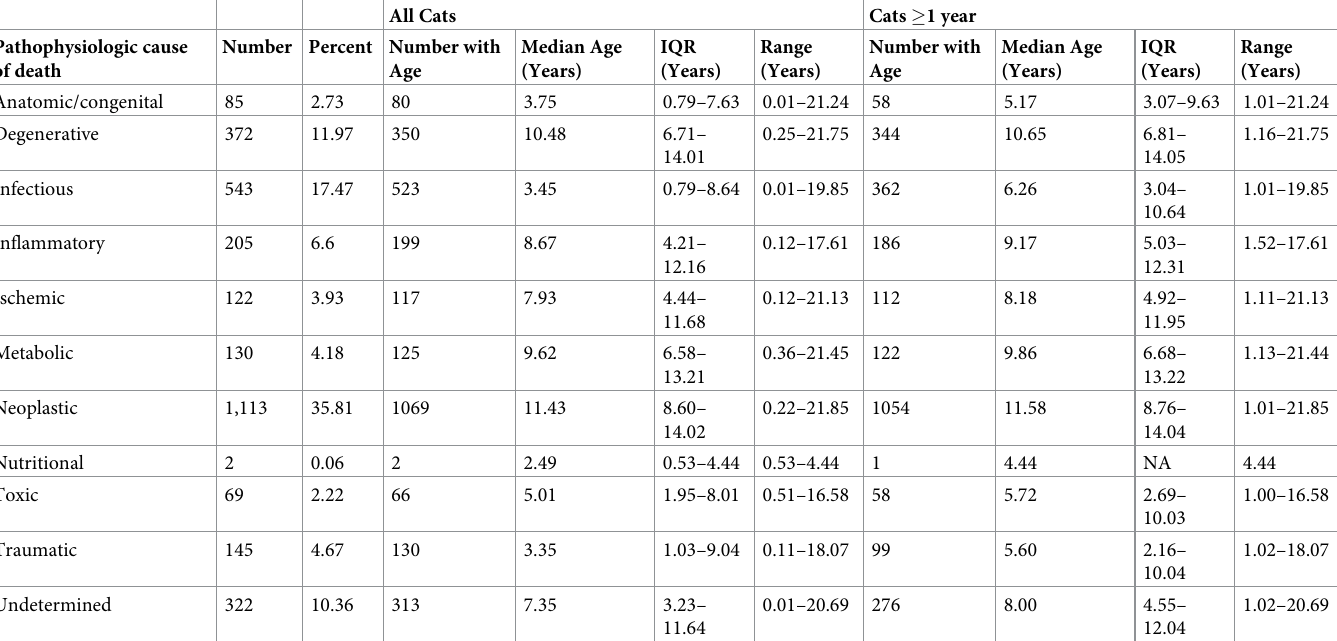
Table 2. Cause of death by pathophysiologic process, based on necropsy findings, for all cats and for cats � 1 year of age. All